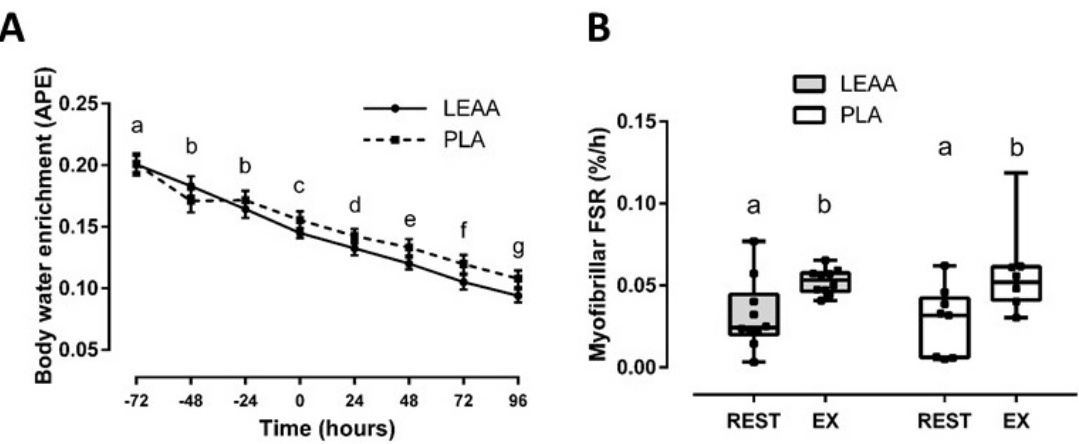
Figure 2. Mean ( ± SEM) body water enrichment over the 8 day exercise trial ( A ) and box-and-whisker plot of myofibrillar fractional synthetic rate before (REST) and during recovery from resistance exercise (EX) in response to LEAA or placebo consumption ( B ). Time points (i.e., hours, panel A; rest vs. exercise, panel B) with di ff erent letters are significantly di ff erent from each other (main e ff ect for time, p < 0.05). APE: atom percent excess; FSR, fractional synthetic rate; EX, integrated 96 h post-exercise period; PLA, placebo.